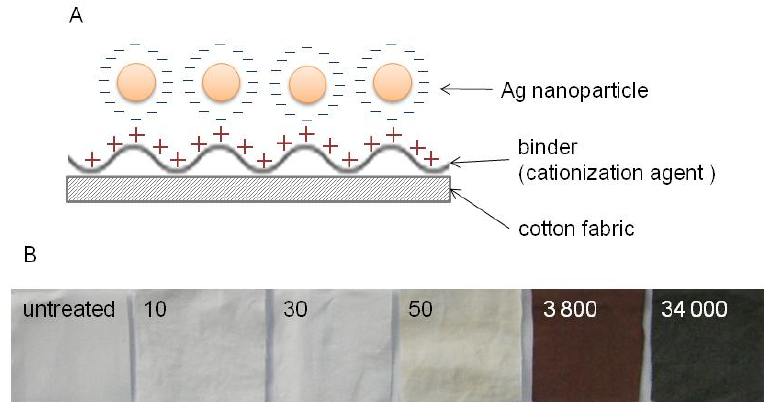
Figure 4. ( A ) Schematic description of the procedure for immobilizing DNA/Ag nanoparticles on to the cotton fabric; ( B ) Photographs of the DNA/Ag nanoparticle immobilized fabric samples. The amounts of immobilized Ag nanoparticles are shown as Ag (ppm).